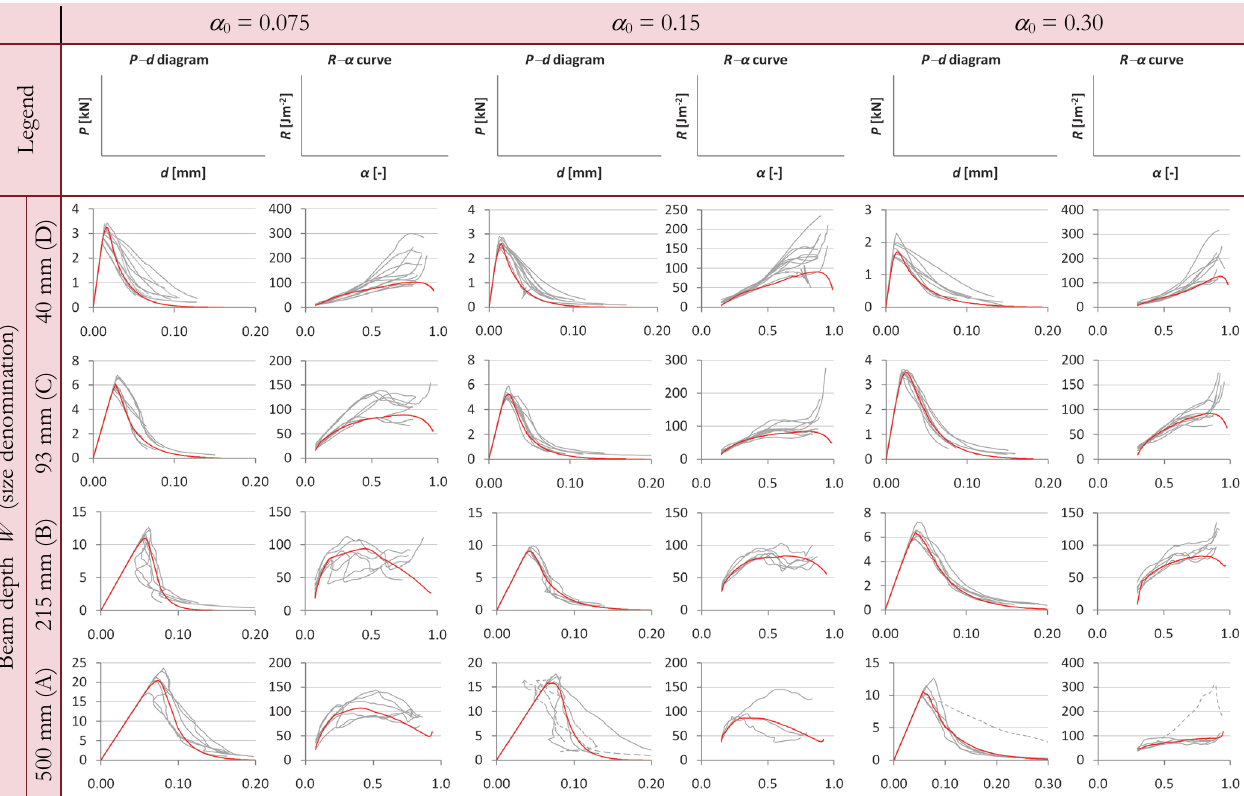
Figure 4: P – d diagrams and corresponding R –  curves for each specimen size W and relative notch length  0 ; red curves correspond to simulated “average”